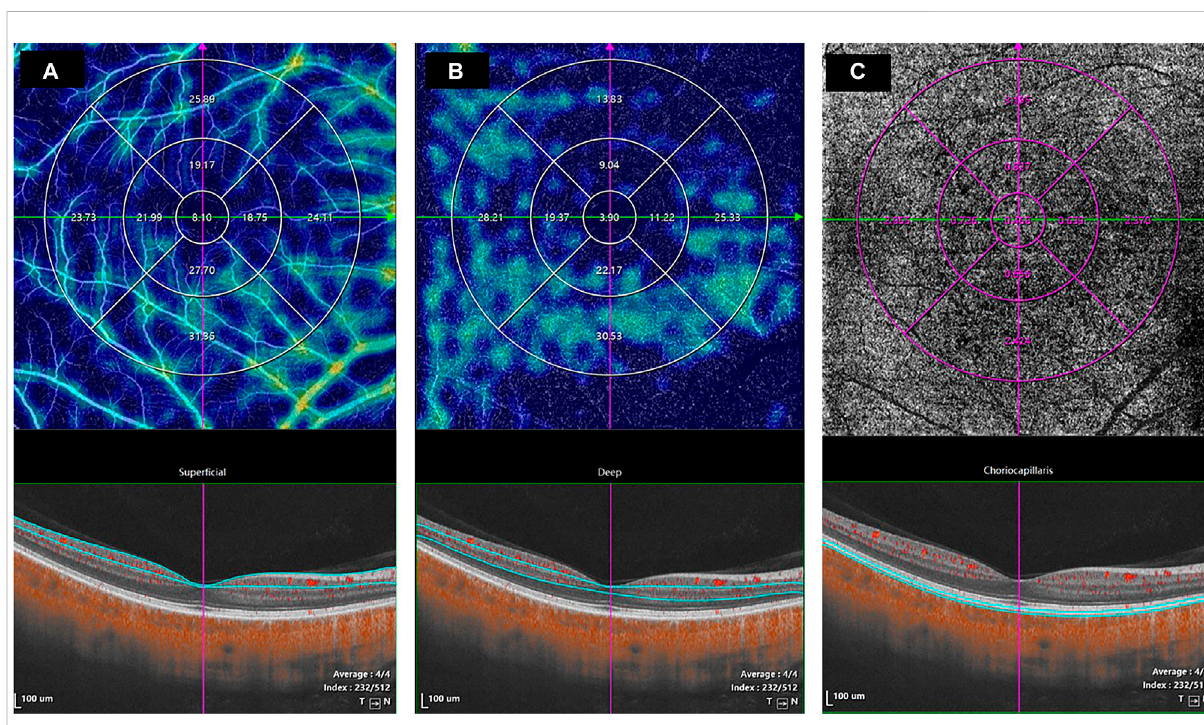
FIGURE 2 The values ofthemicrocirculation parameterswere calculated automaticallybythe system. The top en face images are intensity projections of the regions selected by the blue lines in the bottom images. (A) The retinal super fi cial vascular complex was automatically de fi ned by the system as microvesselsfound5 μ mabovetheinnerlimitingmembranetoone-thirdoftheinterfaceoftheganglioncelllayerandinnerplexiformlayer(GCIPL). (B) The retinal deep vascular complex was automatically de fi ned by the system as one-third of the interface of the GCIPL to 25 μ m below the lower border of the outer plexiform layer. (C) The choriocapillaris was automatically de fi ned by the system as the microvasculature from 10 μ m above the RPE-Bruch ’ s membrane complex to 25 μ m below